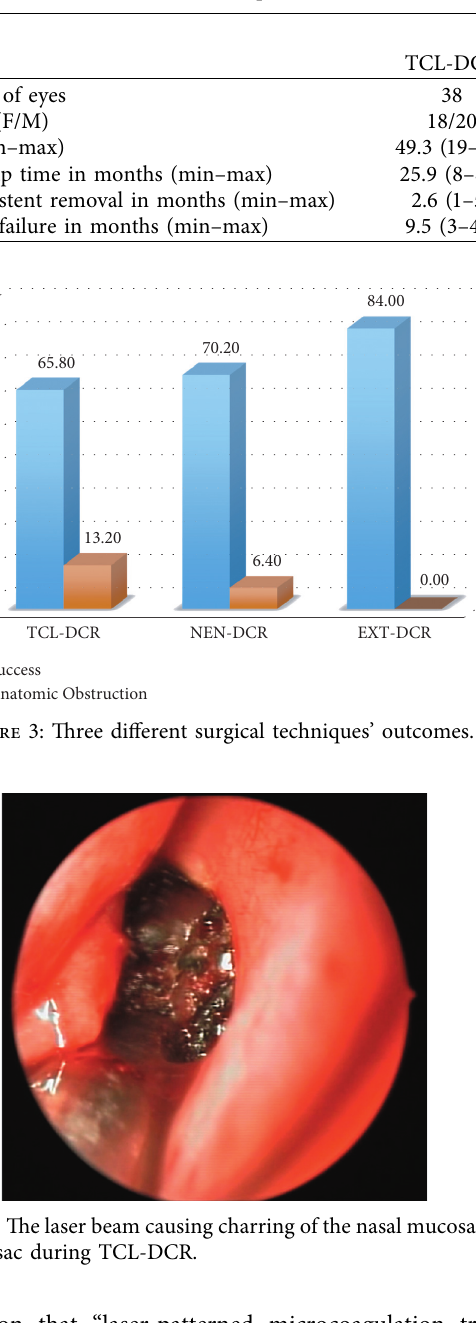
Table 1: Comparison of three distinct groups in terms of demographic and clinical data.